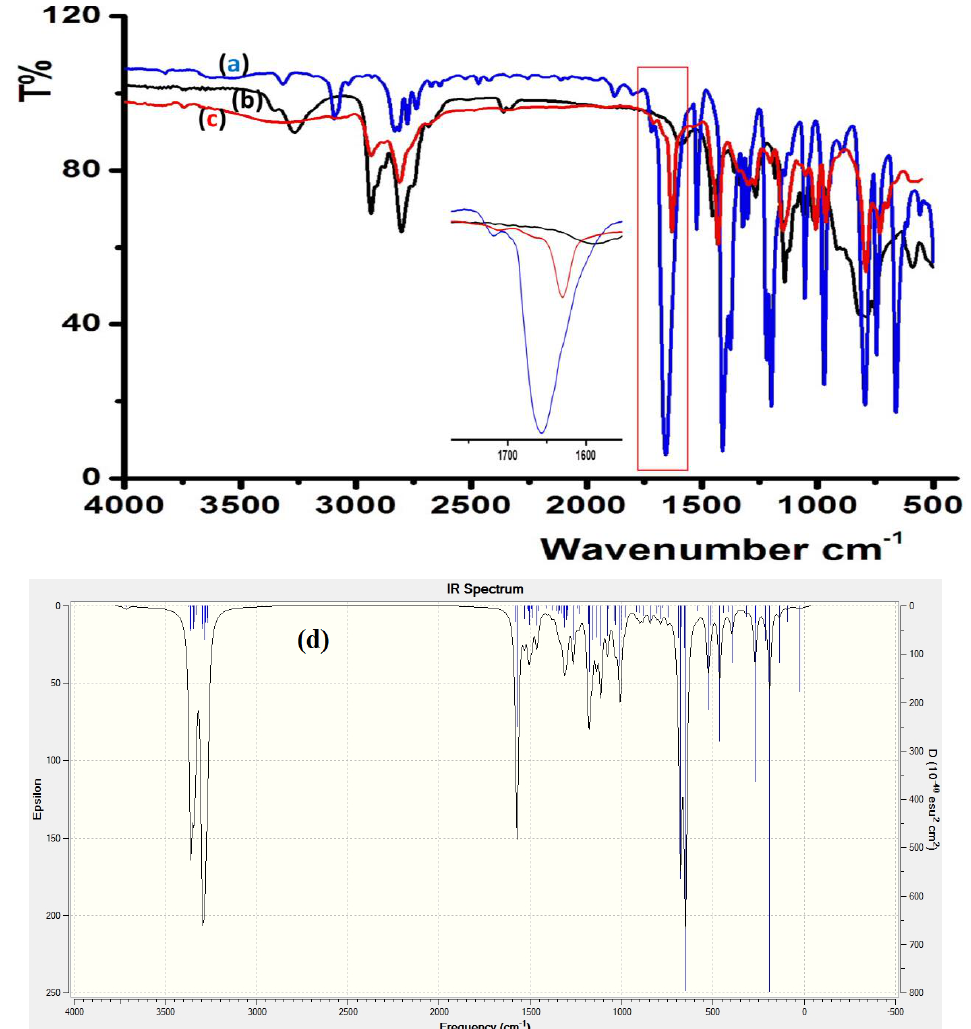
Figure 3. IR spectra of: (a) thiophene-2-carbaldehyde, (b) 2-(Piperidin-4-yl) ethanamine , (c) Figure3. IRspectraof: (a)thiophene-2-carbaldehyde, (b)2-(Piperidin-4-yl)ethanamine, (c)experimental experimental of L2 and (d) DFT/B3LYP 6-311 ++ G (d,p) of L2 . of L2 and (d) DFT / B3LYP 6-311 ++ G (d,p) of L2